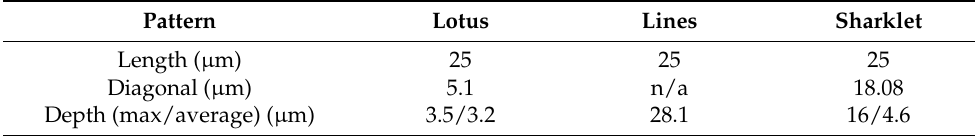
Table 2. The feature size dimensions of three